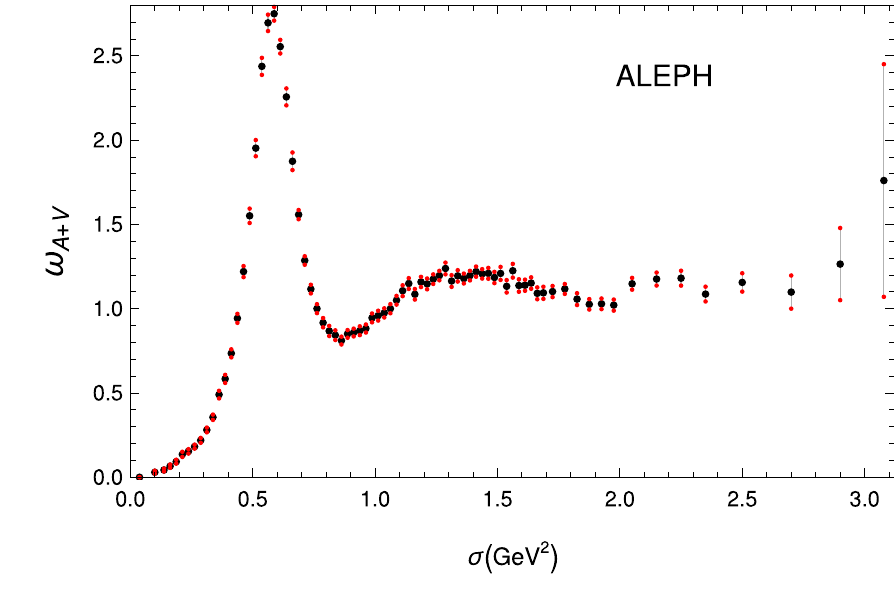
Fig. 2 The spectral function ω(σ) for the (V + A)-channel, as measured by ALEPH Collaboration [2–6]. The extremely narrow pion peak contribution 2 π 2 f 2 π δ(σ − m 2 π ) ( f π = 0 . 1305 GeV) has to be added to this. The last two bins have large uncertainties, so we exclude them, and this means that σ m = 2 . 80 GeV 2 in the